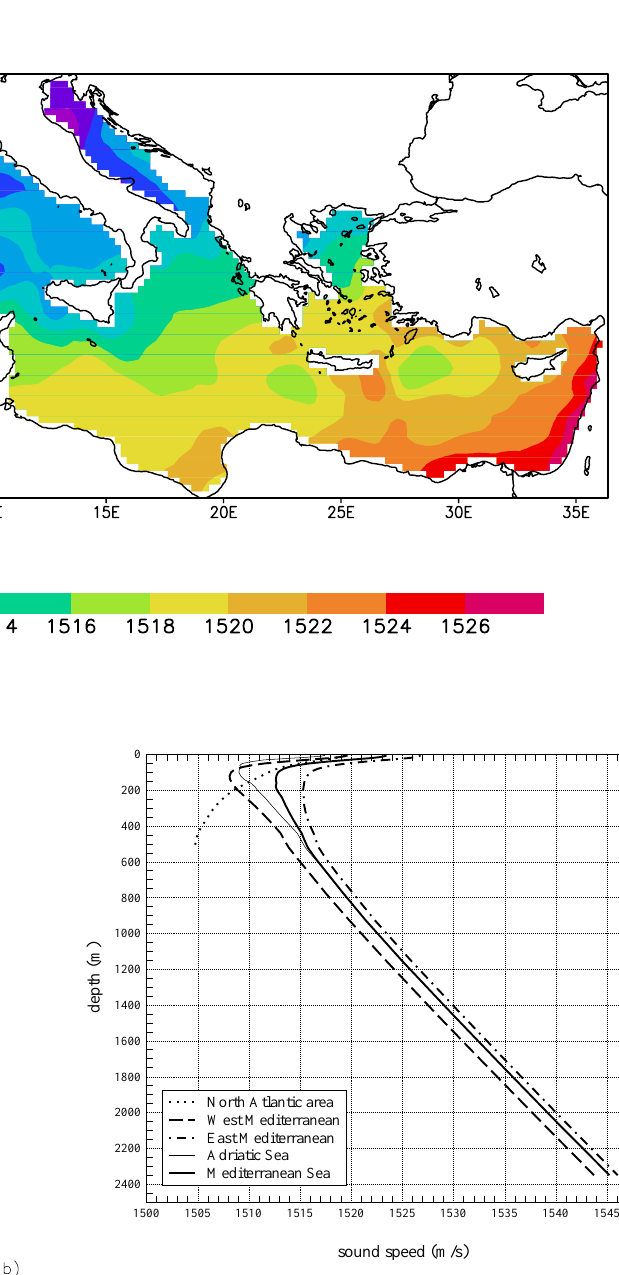
Fig. 4. Sound speed annual mean profiles (m/s) between 5 and 2350m, spatially averaged on the West Mediterranean, the East Mediterranean, the Adriatic Sea, the whole Mediterranean Sea, and the North Atlantic area west of